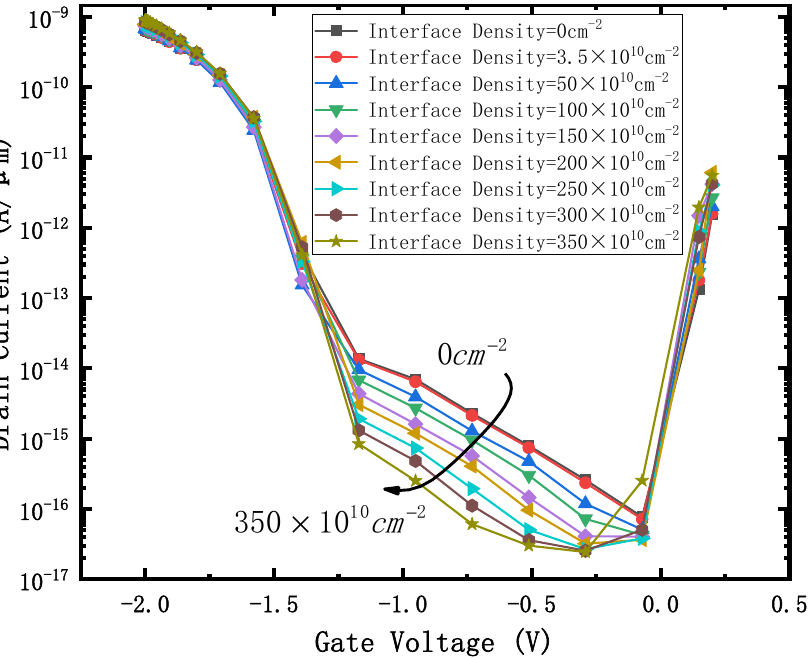
Figure 8. I d -negative gate voltage with different Interface Density.